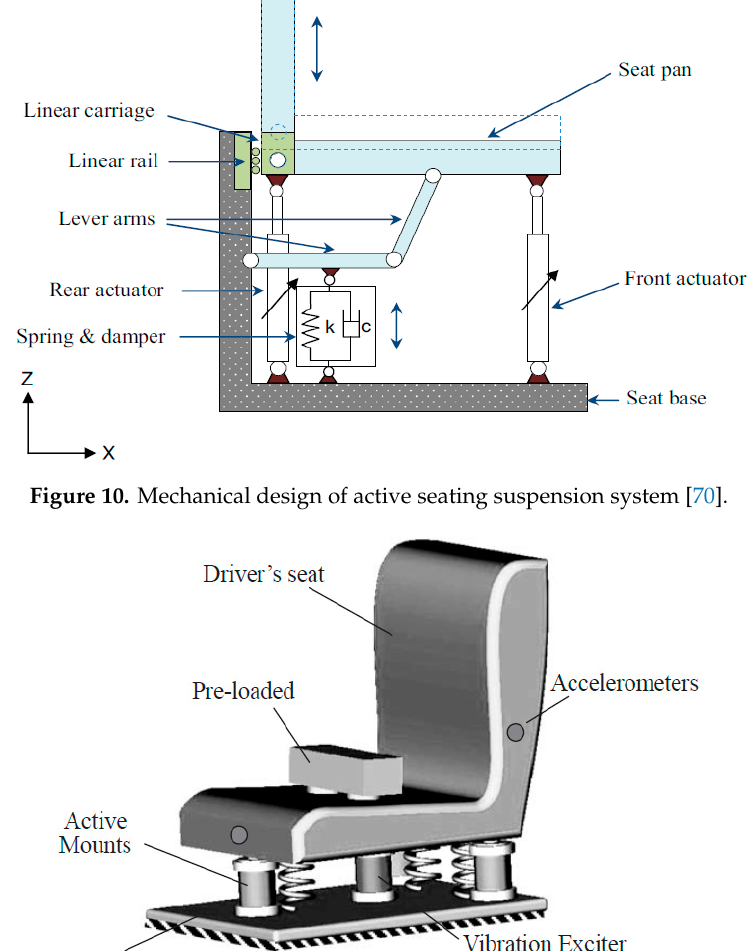
Figure 11. Structure of active seating system [71].